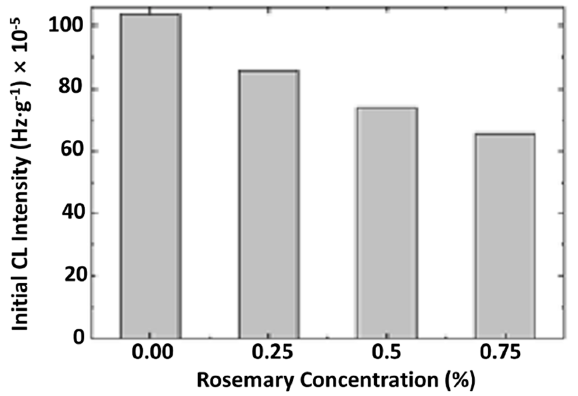
Figure 14. The dependence of the CL intensity on the concentration of powdered rosemary ethanolic extract. ethanolic